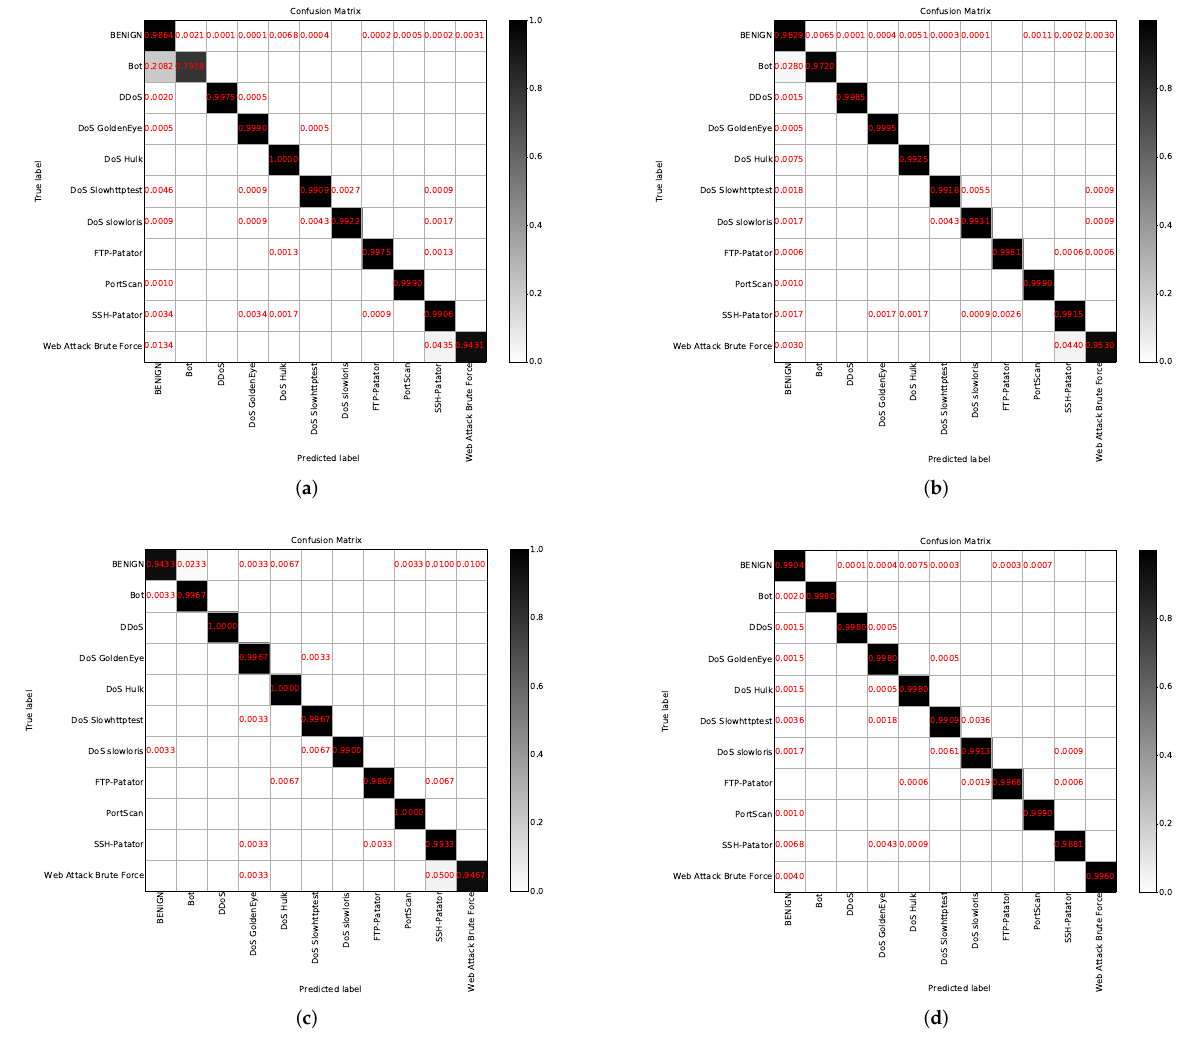
Figure 7. Confusion matrix of comparative experiment. ( a ) Original data; ( b ) Oversampling; ( c ) Un- dersampling; ( d )